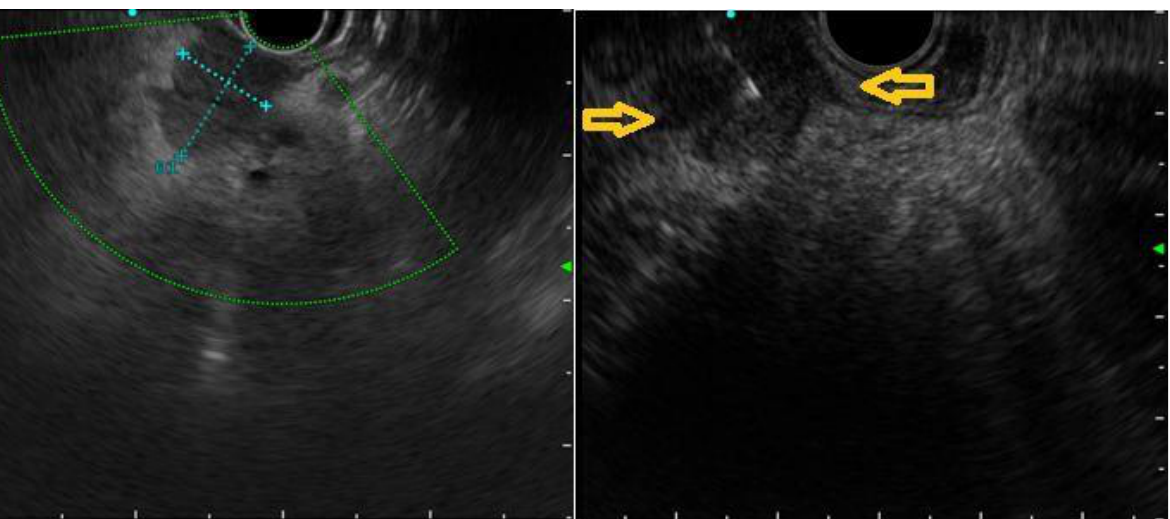
Table 2. EUS features per histology type. Less than 3 patients with fibro-leiomyosarcoma, ovarian cancer, liver and thyroid cancer, Merkel cell tumor and non-Hodgkin lymphoma underwent EUS.